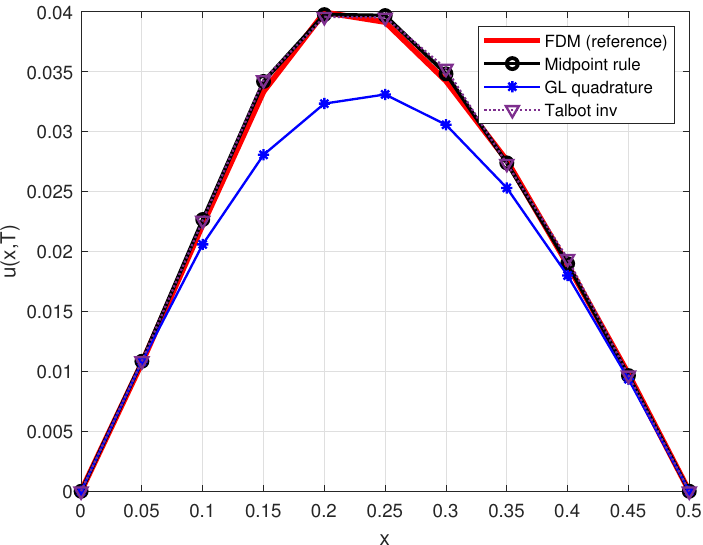
Figure 4. Numerical solution for Example 2 at the moment t = T obtained by considered